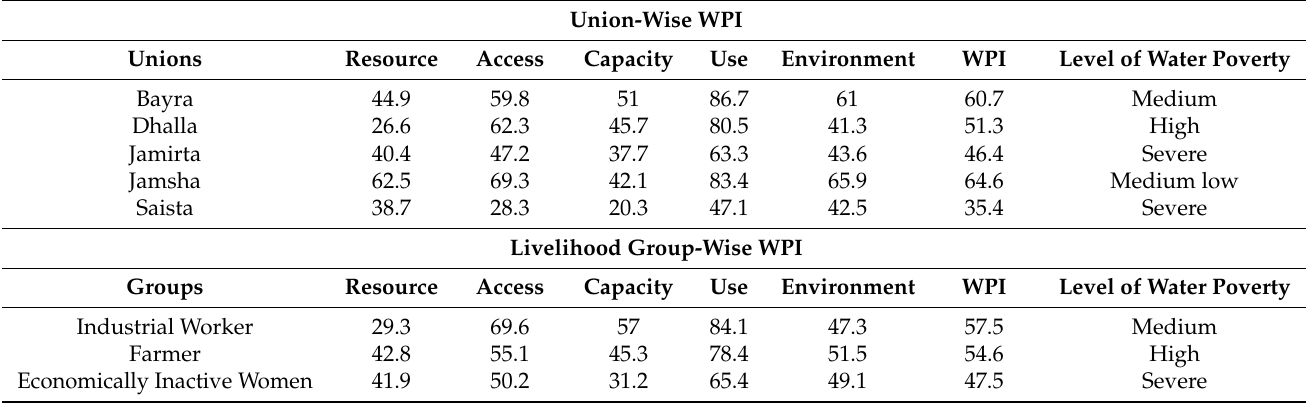
Table 6. WPIs for the unions and the livelihood groups in the study